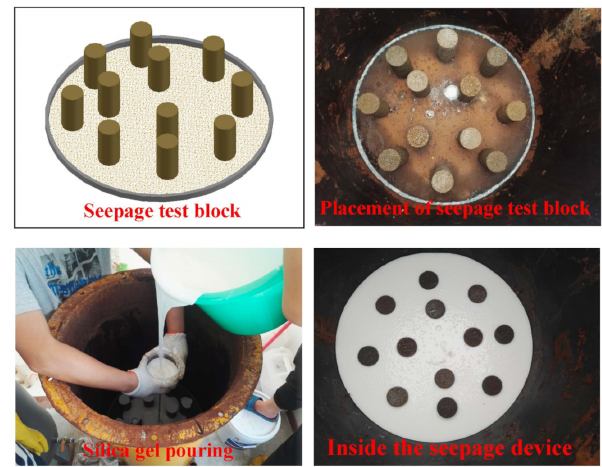
Figure 5. The fabrication process of seepage